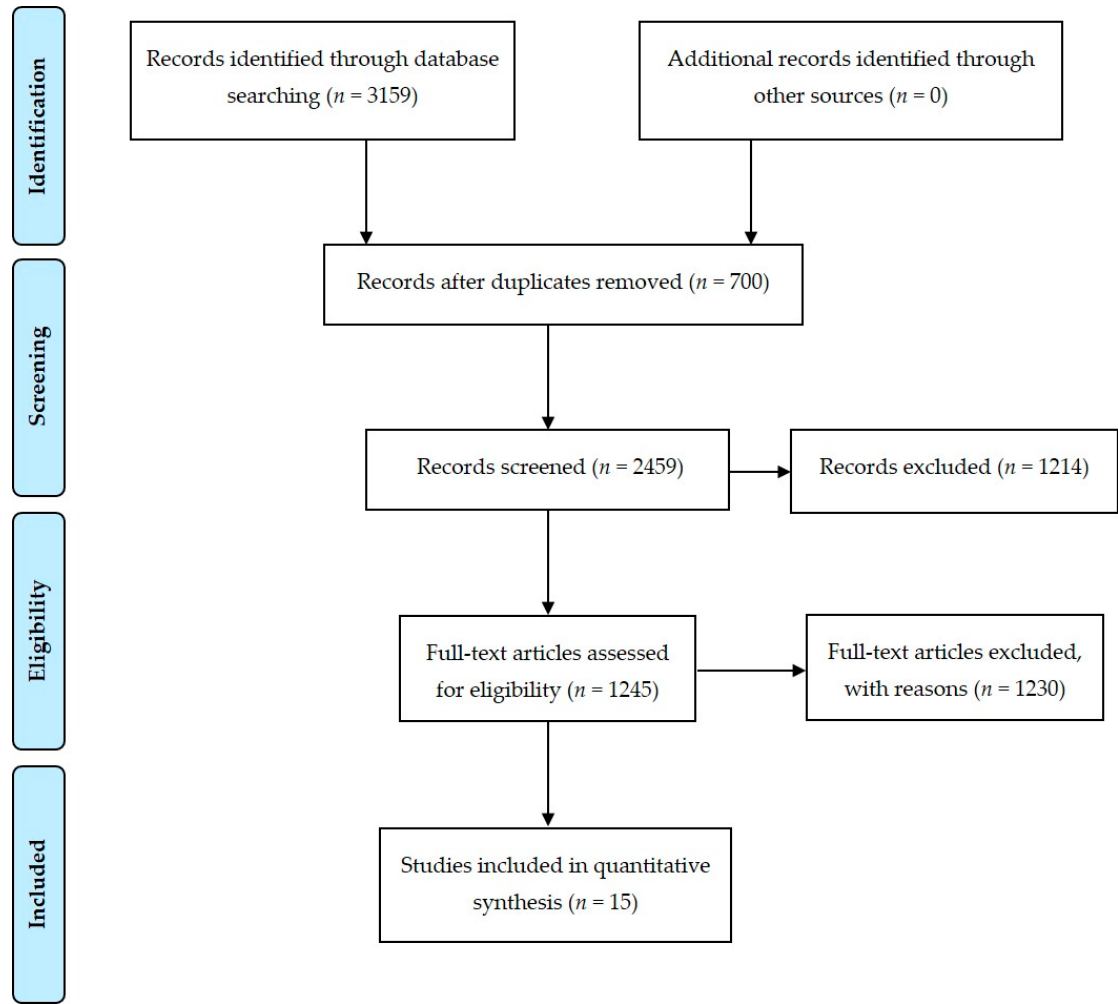
Figure 1. Article selection flow chart for the systematic review according to PRISMA (Preferred Reporting Items for Systematic Reviews and Meta-Analyses) guidelines.